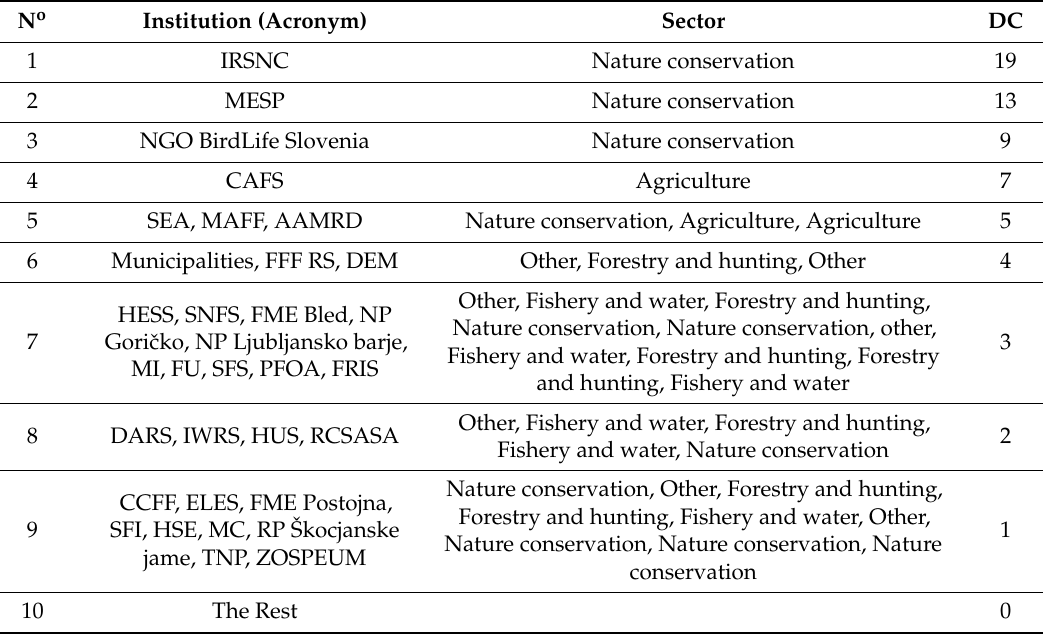
Table A4. Top 10 in the degree of centrality values (DC) for institutions in undirected network of